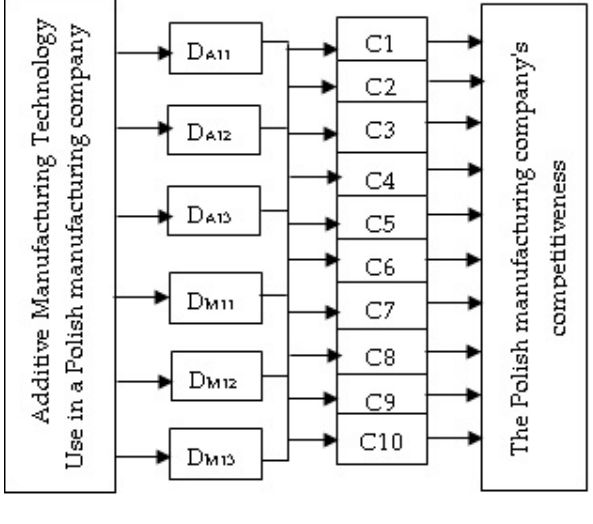
Figure 1. Research model.